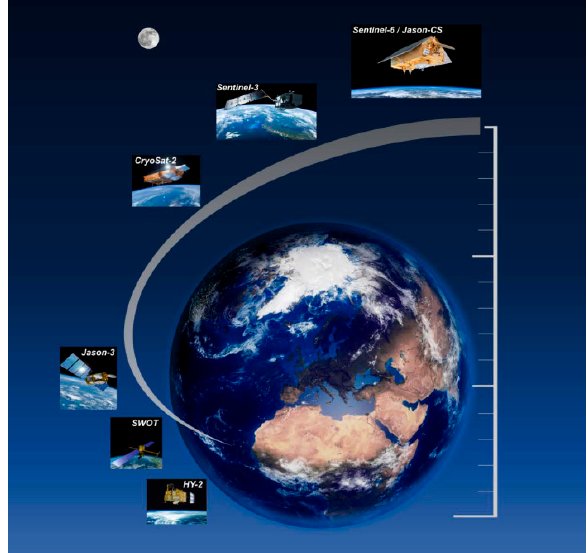
Figure 1. A schematic for the strategy of fiducial reference measurements for altimetry. Long-term, consistent, and continuous sea level records will be achieved only when: (1) The quality of data and products we generate is monitored, (2) proper archiving (databases) of satellite products is carried out, (3) retained data are seamlessly distributed, and (4) the performance of observing systems (satellite altimeters) is continually monitored.